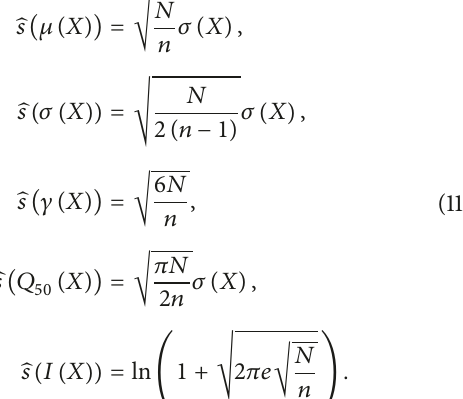
̂𝐻( COD ) together with